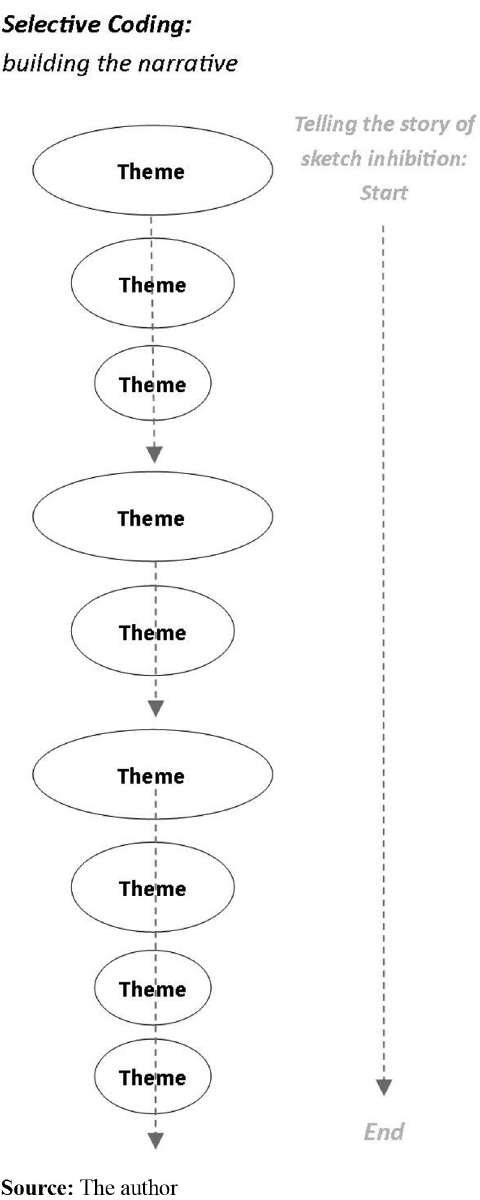
Figure 3. Selective coding to build the narrative of sketch